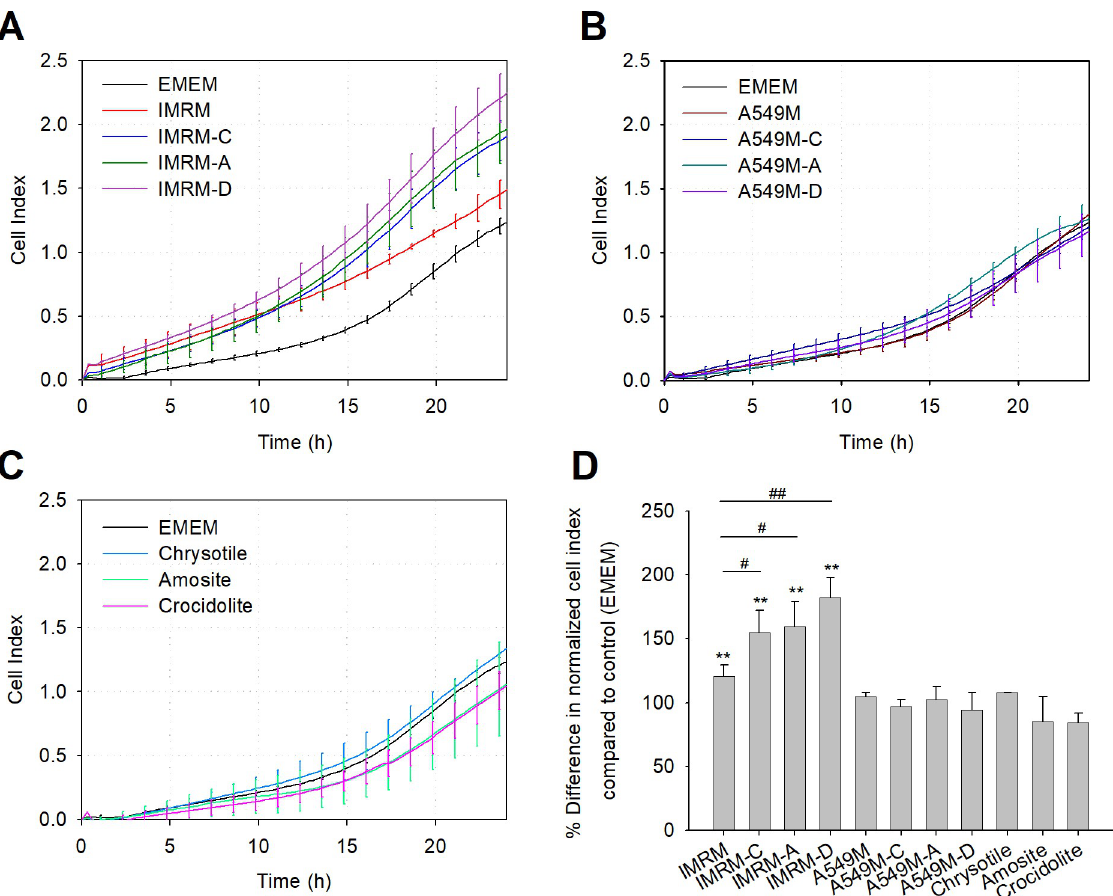
Fig 2. Monitoring the migration of A549 cells. Migration of A549 cells in various media were monitored for 24 h using the RTCA system. Representative graph of migration of A549 cells towards (A) IMRM, IMRM-C, IMRM-A, IMRM-D, and EMEM, (B) A549M, A549M-C, A549M-A, A549M-D, and EMEM, (C) chrysotile, amosite, crocidolite, and EMEM. (D) Comparison of calculated NCI values of migration in all media at 24 h. Experiments were performed in quadruplet and presented as mean ± SD. Quantification of observed migration revealed significance., �� P < 0.01 compared to EMEM and #P < 0.05, ##P < 0.01 compared to IMRM.